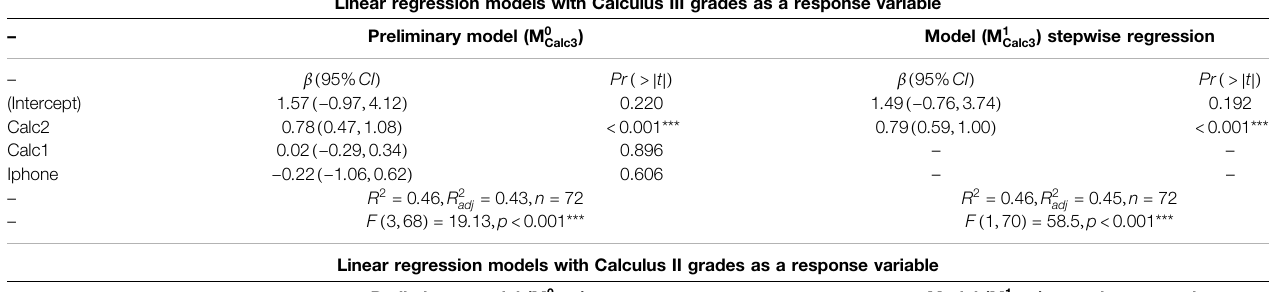
TABLE 5 | Linear models with grades in Calculus II, Calculus III, and Elementary Differential Equations as response variables. Linear regression models with Calculus III grades as a response